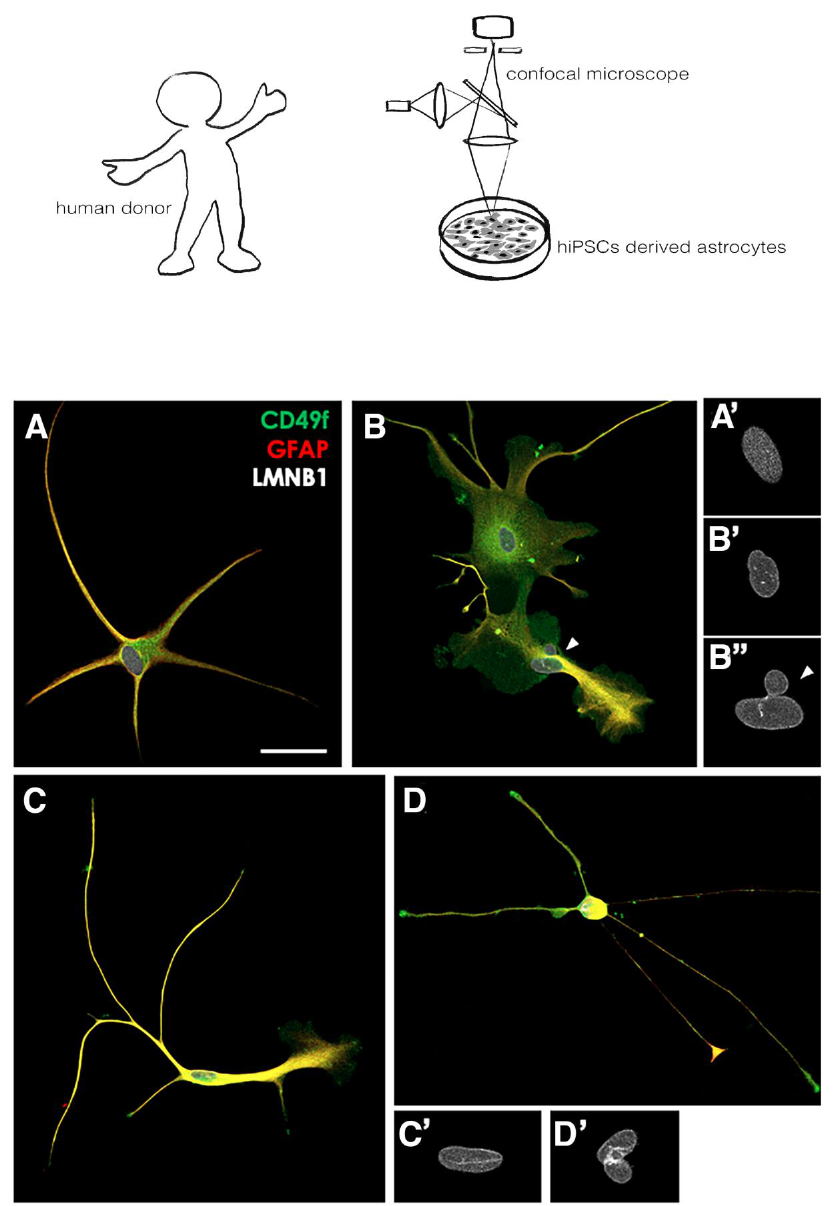
Figure 1. hiPSC-derived astrocytes display different morphological nuclear LMNB1-related patterns. Human pluripotent stem cells derived from healthy donors were differentiated to neural progenitors, expanded as spheres, further matured into authentic astrocytes (see Section 2), and analyzed by confocal microscopy ( A ). During this maturation step, they acquired typical astroglial markers (GFAP, CD49f) and morphologies ( B – D ). Astrocyte nuclei were classified into 5 categories, corresponding to distinct nuclear morphologies based on the LMNB1 staining pattern: homogeneous ( A’ , with no sign of LMNB1 accumulation), dotted ( B’ , with dots of LMNB1 accumulations), wrinkled ( C’ , with stripes of LMNB1 accumulations), forming crumples, ( D’ ) or forming micronuclei ( B” ). Magnification in A’ , B’ , B” , C’ and D’ shows LMNB1 staining details. GFAP, Glial Fibrillary Acid Protein; LMNB1, Lamin B1. Scale bar: 50 µ